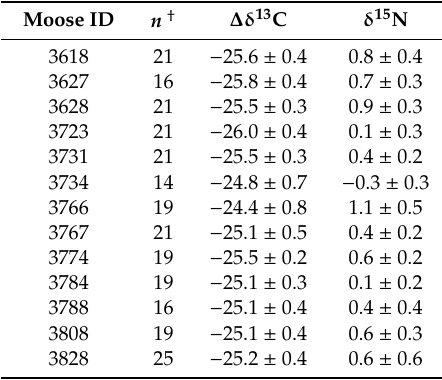
Table 1. Sample size and mean ( ± SD) stable isotope values measured along the length of adult female moose hooves on the east side of Isle Royale.